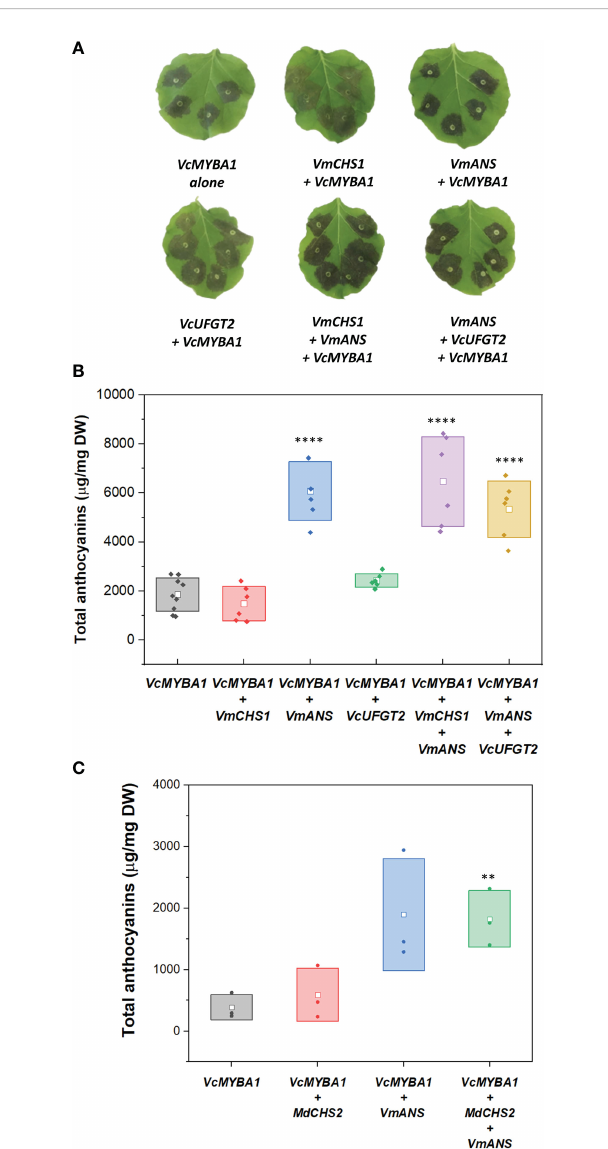
FIGURE 3 (A) Images of N. benthamiana leaves in fi ltrated with different combinations of VcMYBA1, VmCHS1 , VmANS , and VcUFGT2 . The combinations of genes used are indicated below each leaf image. Images were taken at 5 days post-in fi ltration. (B) Total anthocyanins from leaves in fi ltrated with different gene combinations. (C) Total anthocyanins from leaves in fi ltrated with MdCHS2 . Filled dots represent data points from each biological replicate. Empty squares represent the mean concentration value of each treatment. Boxes represent the mean ± one SD from at least three biological replicates. Statistical analysis from pairwise comparison with VcMYBA1 control samples (Student ’ s t-test, N ≥ 3, a = 0.05), p-value < 0.005 is indicated by **; p-value < 10 -4 is indicated by